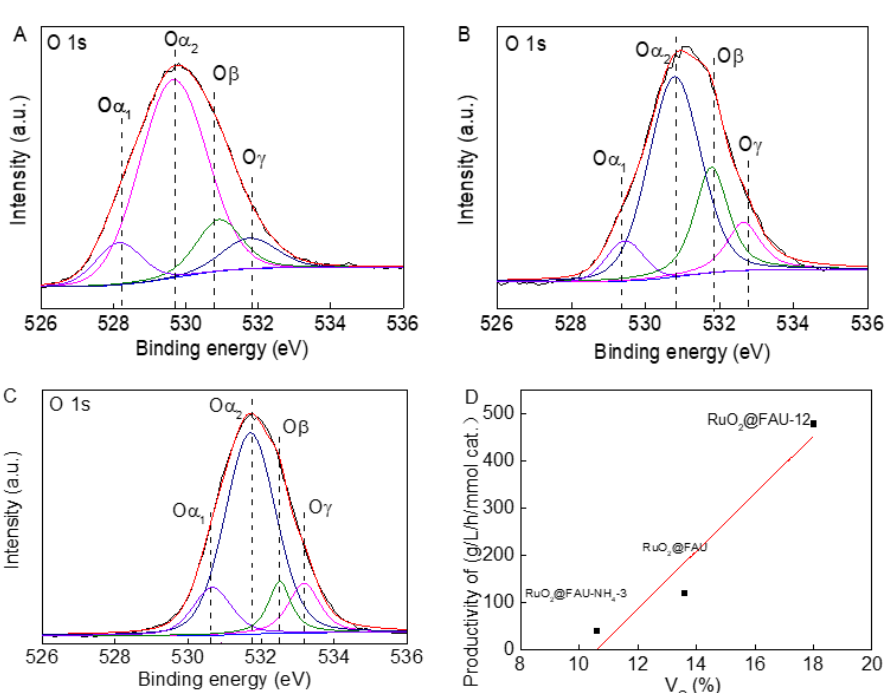
Figure 7. High-resolution spectra of XPS of RuO 2 @FAU ( A ), RuO 2 @FAU-12 ( B ), RuO 2 @FAU-NH 4 -3 ( C ) for O 1s, and variation of cadaverine productivity with oxygen vacancies percentage in RuO 2 @FAU, RuO 2 @FAU-12, and RuO 2 @FAU-NH 4 -3 catalysts ( D ). Based on the XPS peak differentiating results for O 1s, the oxygen vacancies percentage was calculated by using area normalization method.